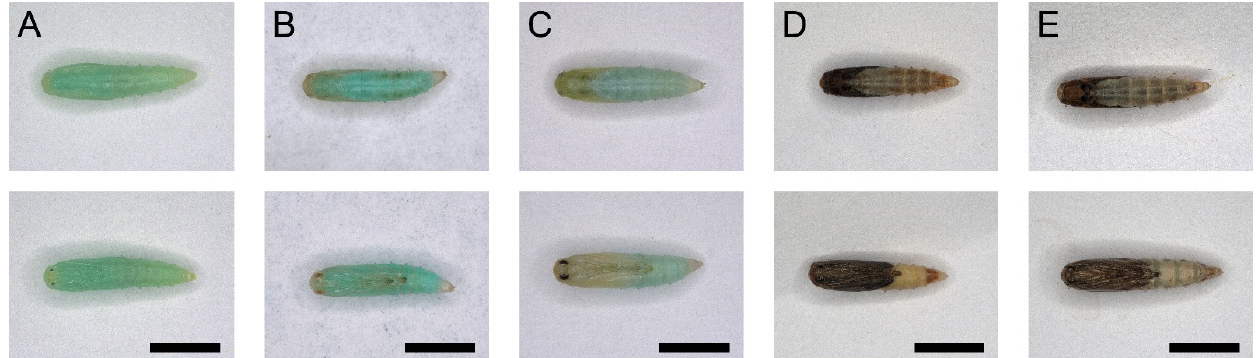
Figure 4. The dorsal and ventral view of the pupa development of P. xylostella . Scale bar = 1000 μ m. n = 36. ( A – D ) Stage I of the pupa development of P. xylostella . ( A ) The pupa was evenly green at the end of L-P metamorphosis. ( B ) The compound eyes, antennae, and appendages turned yellow distally. ( C ) The compound eyes turned black. Meanwhile, the antennae, appendages, wings, and thorax turned yellow. The last two segments of the abdomen turned yellow with other segments kept green. ( D ) The antennae, appendages, wings, and thorax turned black. The last two segments of the abdomen turned brown, and the other segments turned yellow. ( E ) Stage II of the pupa development of P. xylostella : Intersegmental membrane of the pupa inflated with the metallic reflection on the scale of the pharate adult because of the full absorption of the molting fluid.